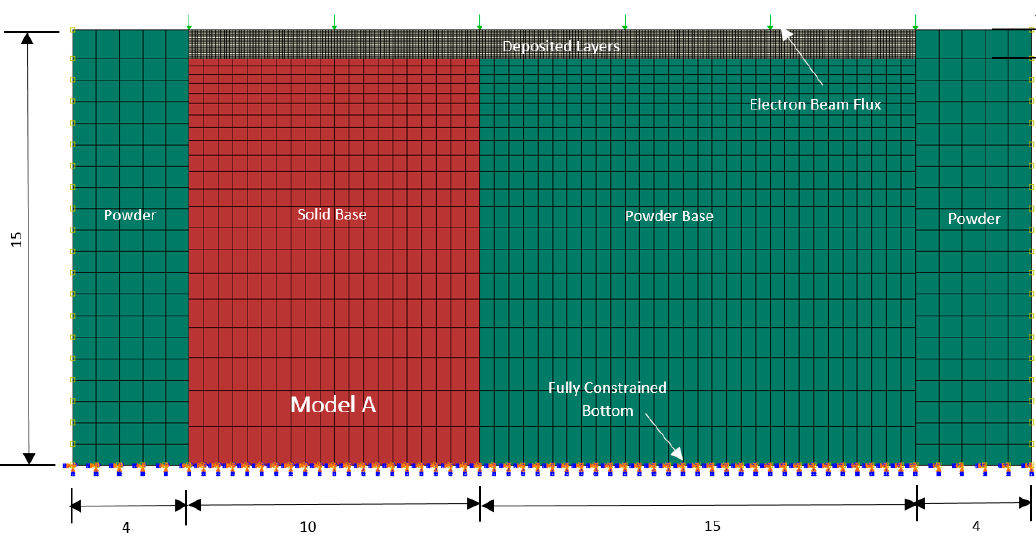
Figure 5. Model A, 2D finite element (FE) model for electron beam melting study of overhang structure (all dimensions are in mm).